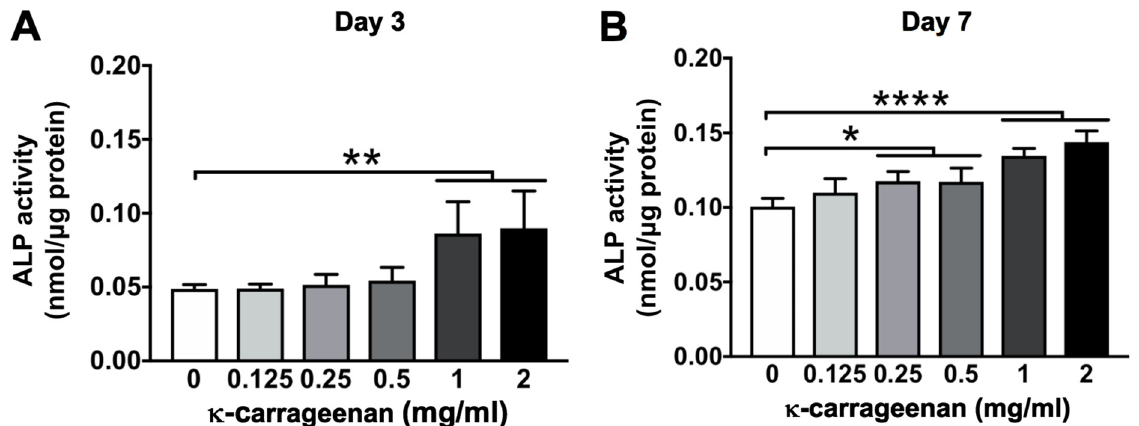
Figure 7. K-carrageenan enhanced ALP activity of MC3T3-E1 pre-osteoblasts at day 3 and 7. ALP activity at ( A ) day 3, and ( B ) day 7. Values are mean ± SD from 4 independent experiments. Significant effect of κ -carrageenan, * p < 0.05, ** p < 0.01, **** p < 0.0001. ALP, alkaline phosphatase.